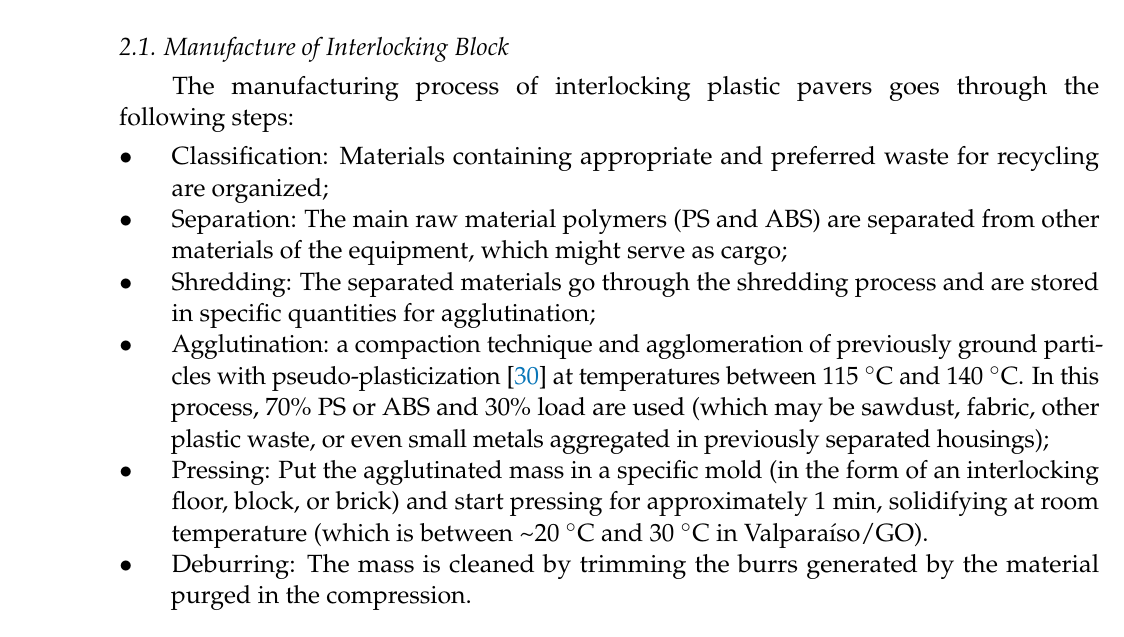
Figure 2. Process flowchart describing the steps of this work.